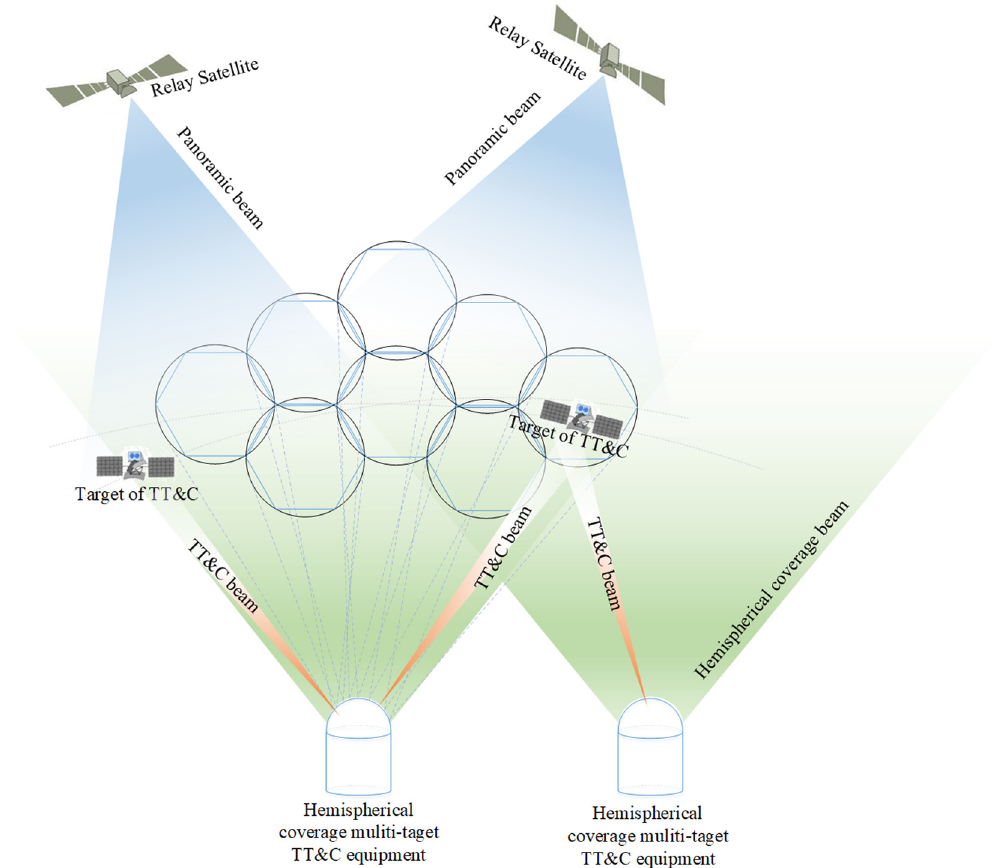
Figure 4: Schematic diagram of AOE TT&C coverage